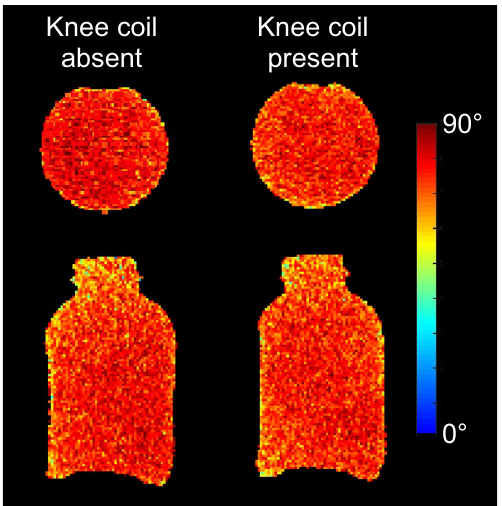
Figure 9. Axial (top row) and sagittal (bottom row) flip angle maps measured with the 6-channel knee coil absent (left) and present (right) illustrate negligible interaction with the system body coil during transmission.